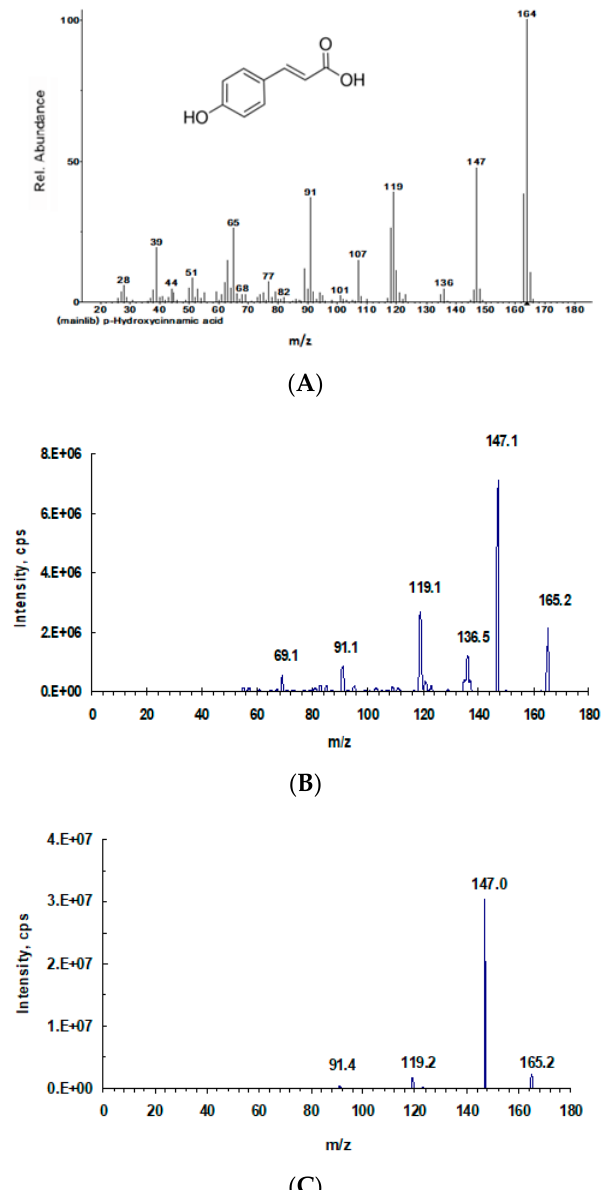
Figure 3. Relevant tandem mass (MS/MS) spectra. ( A ) trans-p-Coumaric acid spectrum (from NIST 14 mass spectral library); ( B ) isolated and purified compound ( 1 ); ( C ) trans-p-Coumaric acid standard (Sigma).